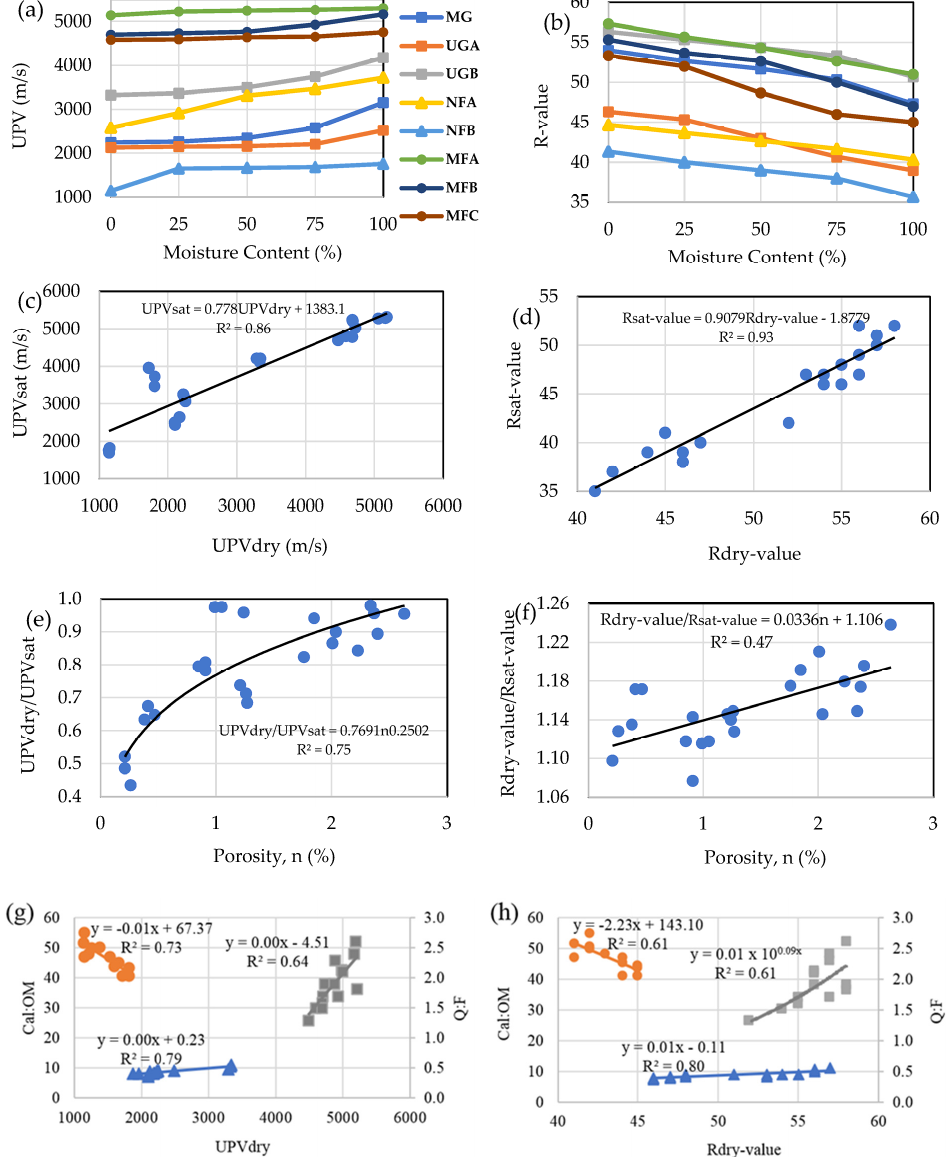
Figure 5. Variation of UPV dry and R dry ( a , b ) with moisture content ( c ) UPV sat vs. UPV dry ( d ) R sat-value vs. R dry-value ( e ) UPV dry /UPV sat vs. Porosity ( f ) R dry-value /R sat-value vs. Porosity. ( g ) Cal:OM vs. UPV dry ( h ) Cal:OM vs. R dry-value The R-values (Figure 5b) show a consistent negative trend with moisture content, with a decrease of 10 to 15% from dry to completely saturated. Grain softening and